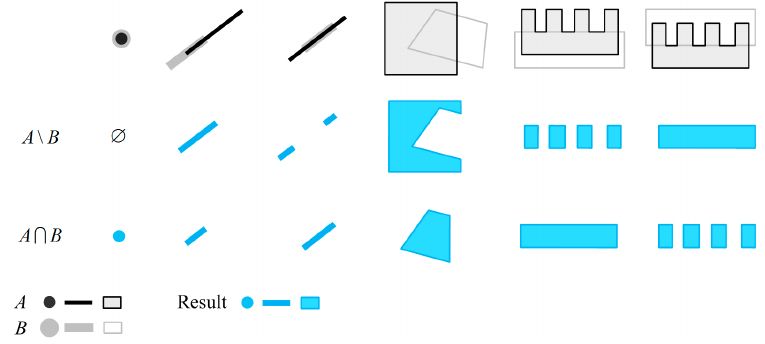
Figure 6. Boolean set operations for footprint points, edges and faces.